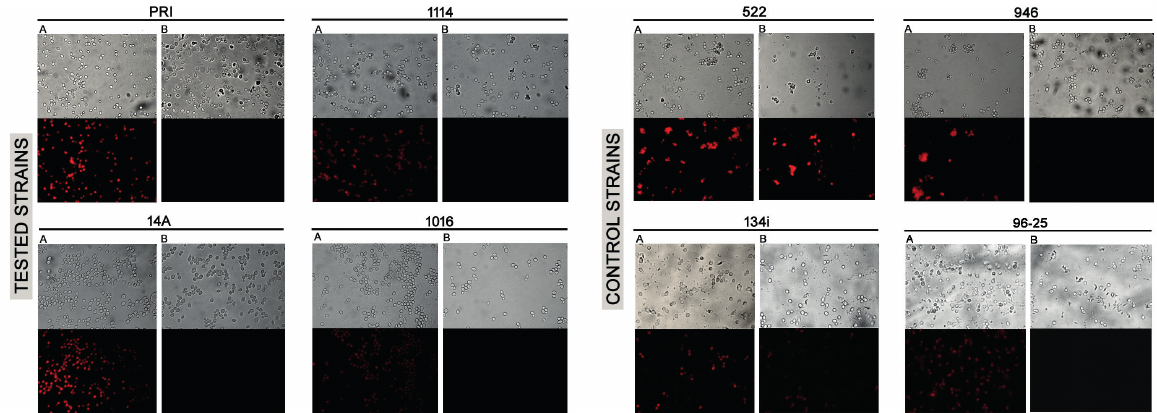
Figure 1 - Fluorescence microscopy of C. albicans isolates in the presence of fluorescent substrates, in a 40x magnification. C. albicans strains PRI, 14A, 1114 and 1016 were treated with rhodamine 6G, an ABC pumps substrate ( A columns) , and nile red, a MFS pumps substrate ( B columns). Images show that all strains retained rhodamine 6G. Nonetheless, only strains 522 and 134i retained red nile, while PRI, 1114, 14A, 1016, 946 and 96-25 strains extruded this compound. Saccharomyces cerevisiae strains 522 (mutant strain that lacks efflux pumps) and 946 (mutant strain that overexpresses MFS transporters) were used as controls, as well as C. albicans strains 134i (fluconazole-susceptible clinical isolate) and 96-25 (fluconazole-resistant clinical isolate). Results are representative of at least three independent